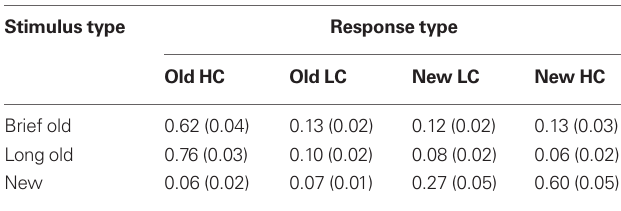
Table 1 | Mean recognition endorsement rates for high confidence (HC) and low confidence (LC) responses.